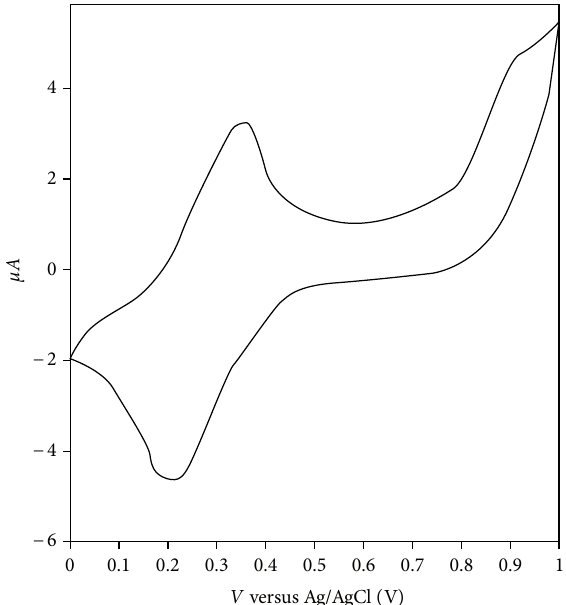
F 5: Cyclic voltammogram of